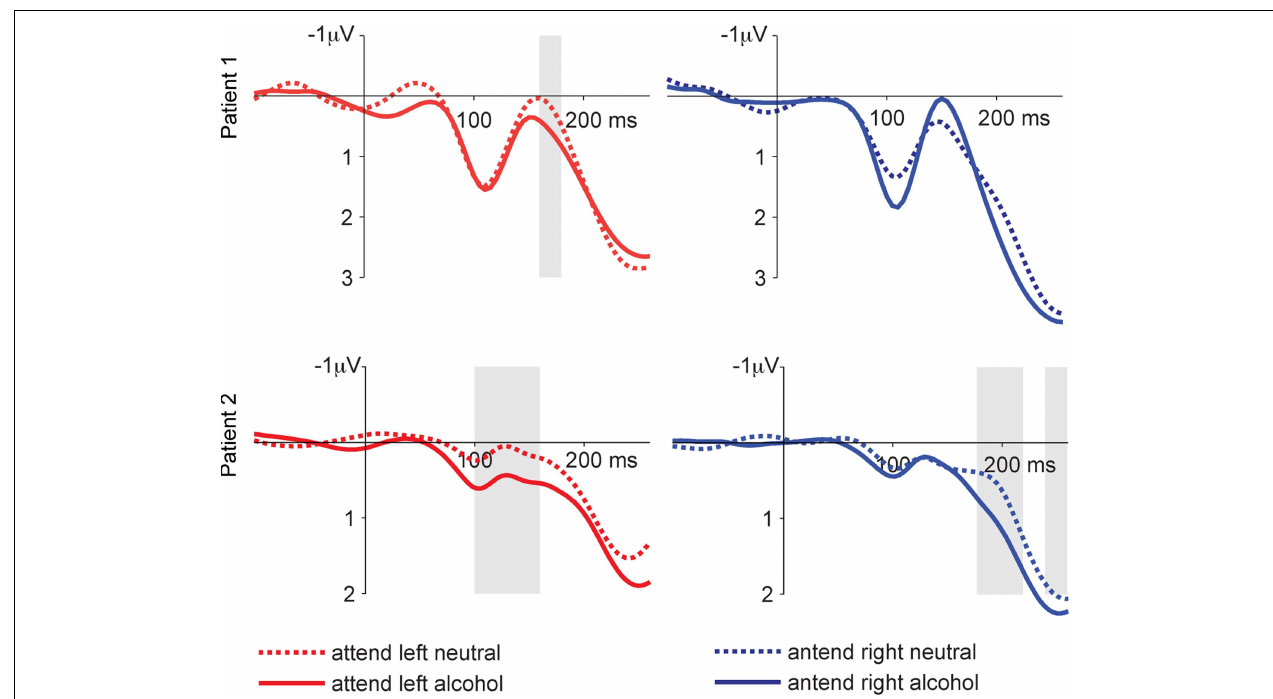
determined by the bootstrapping method (see text). This pattern of results suggests that alcohol-related cue information infl uences neural activity in the NAcc, even if this information is task irrelevant and presented outside the attentional